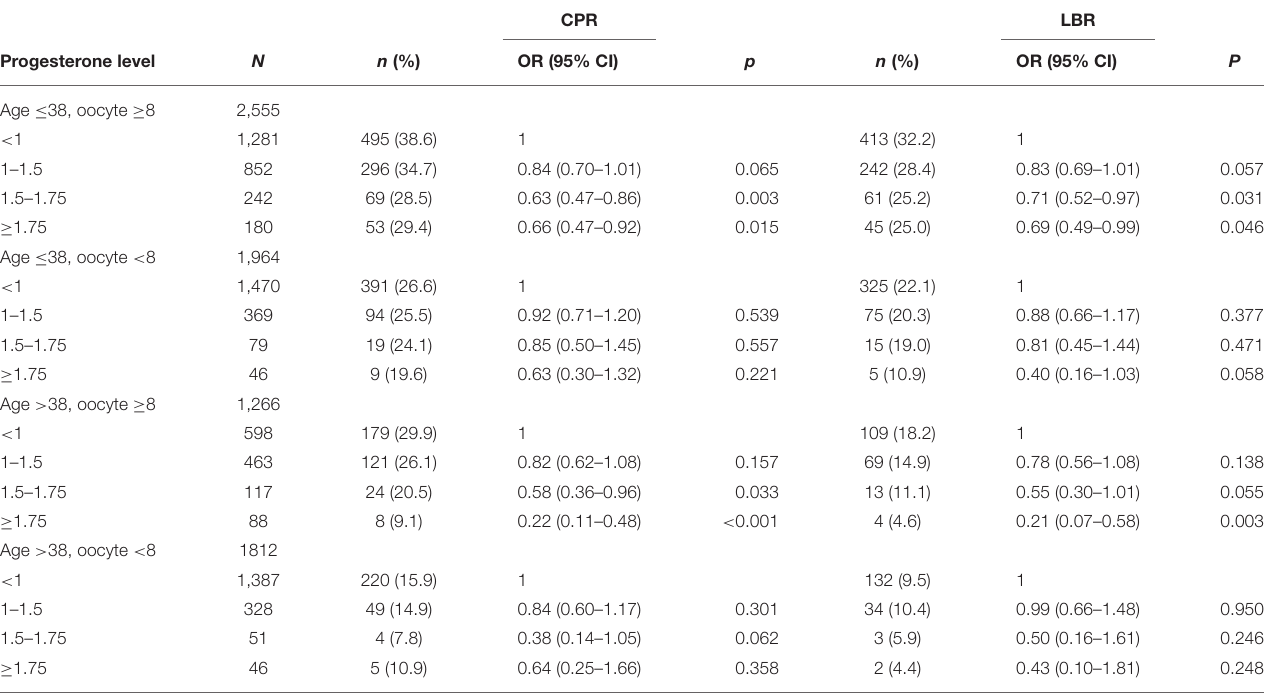
TABLE 3 | D3 embryo transfer subgroup: influence of P levels on clinical pregnancy rate (CPR) and live birth rate (LBR), stratified by woman age and number of retrieved oocytes and corrected for number of embryo transfer.